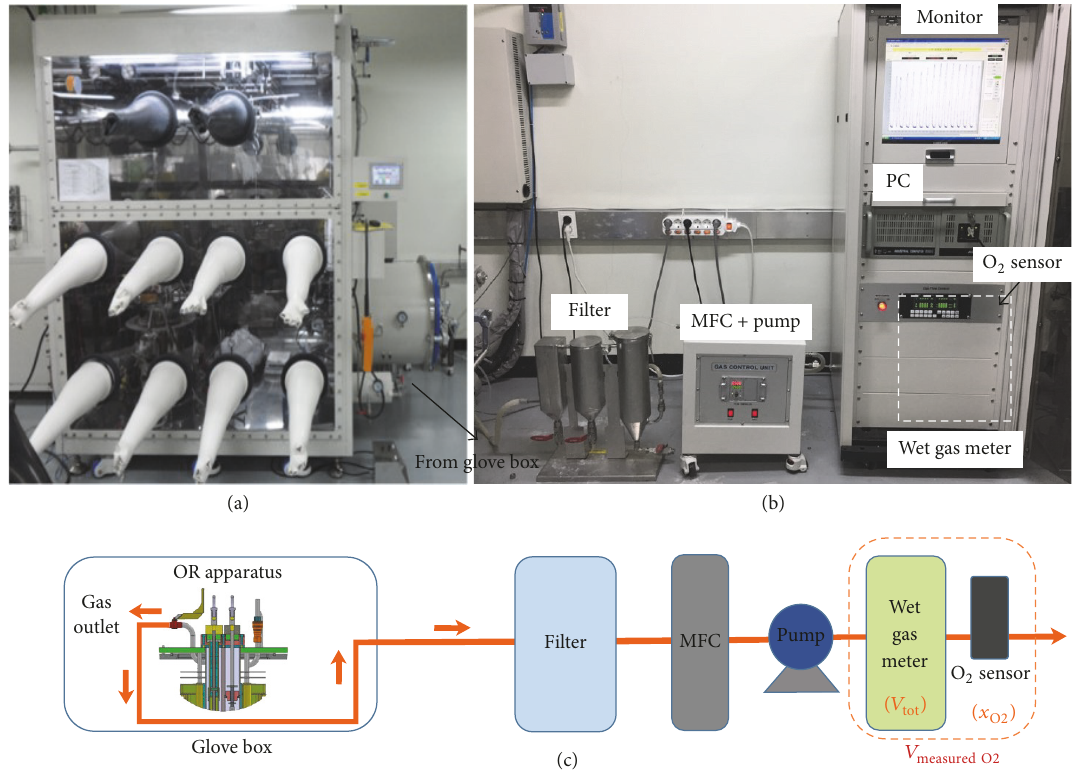
Figure 1: Setup for the present study: photographs of (a) Ar glove box equipped with the OR apparatus, (b) instrumentation for in situ measurement of O 2 gas generated from the Pt anode during the OR process, and (c) schematic of the flow of O 2 gas from the anode of the OR apparatus to the